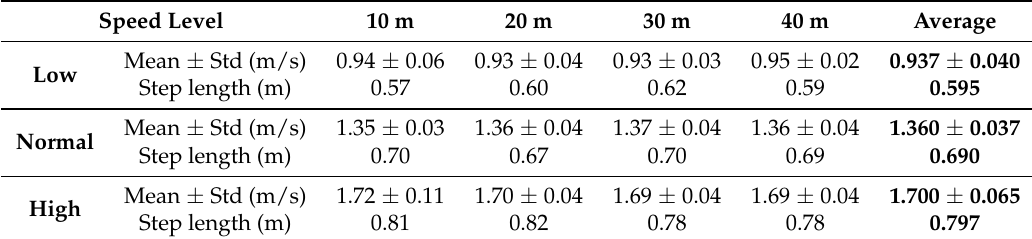
Table 1. Speed information and step-length